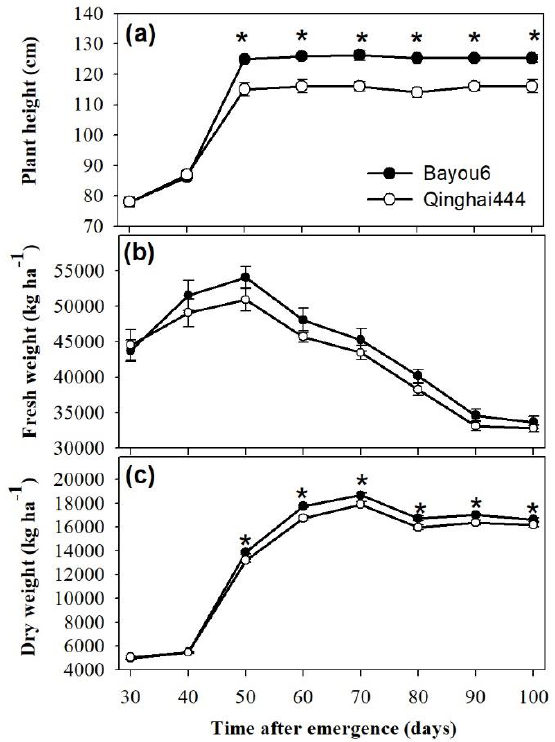
Figure 1. Dynamic changes in plant height ( a ), fresh weight ( b ), and dry weight ( c ) of aboveground biomass for the two oat species during the growing season. * indicates significant difference ( p < 0.05) between the two oat species (Bayyou6 and Qinghai444) under the same growing stage. Data are means ± SE ( n = 4).